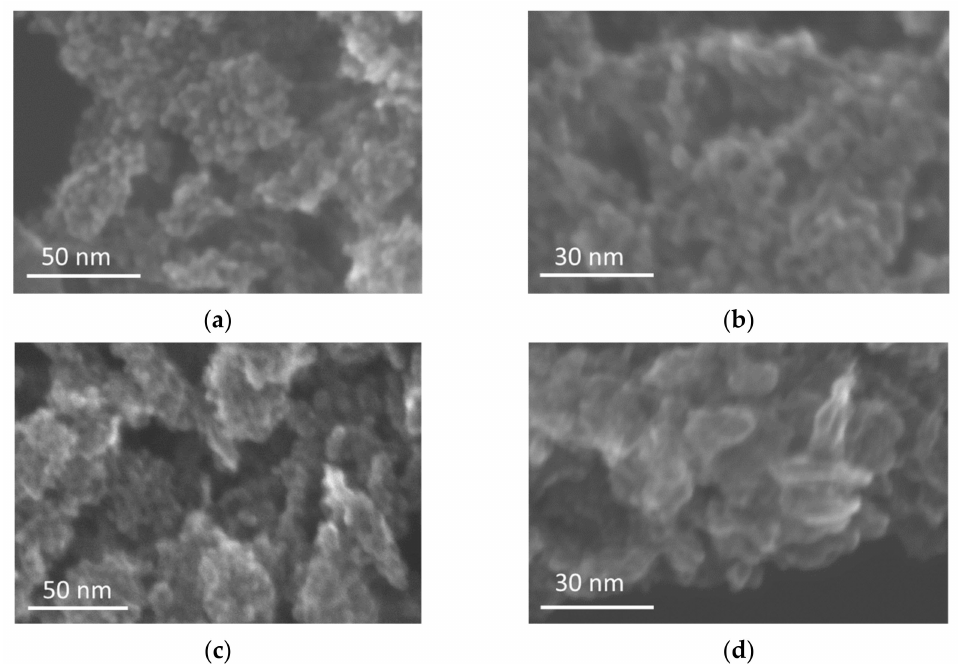
Figure 5. STEM images of: ( a , b ) P25; ( c , d ) P25-R1.